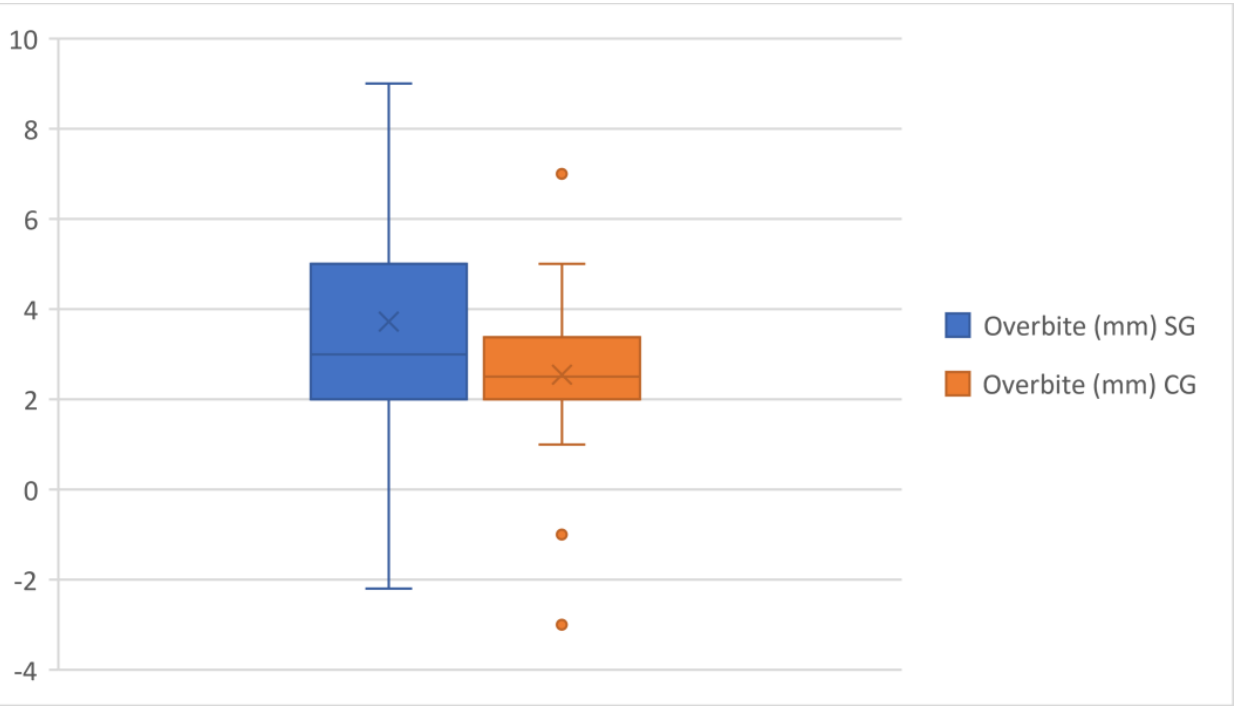
Figure 6. Overbite comparison in the study group and control group.